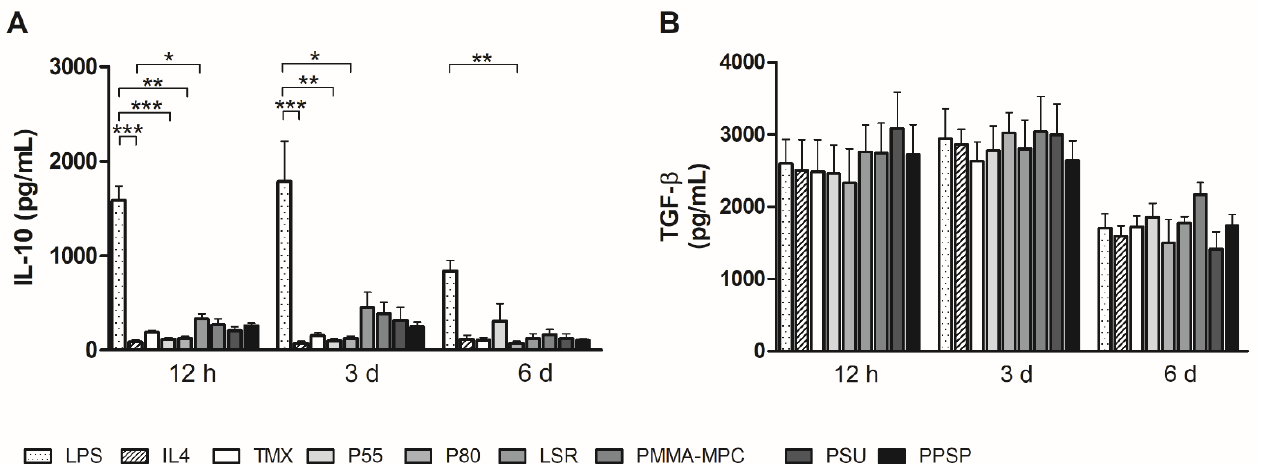
Figure 5. Unmodified and modified liquid silicon rubber (LSR) induce anti-inflammatory cytokine production. Cytokine production of ( A ) IL10 ( B ) TGF β was measured by using enzyme-linked immunosorbent assay. Data are represented as mean + SE Mean of six independent experiments. Significant results are indicated as * p < 0.05; ** p < 0.01; and *** p < 0.001.